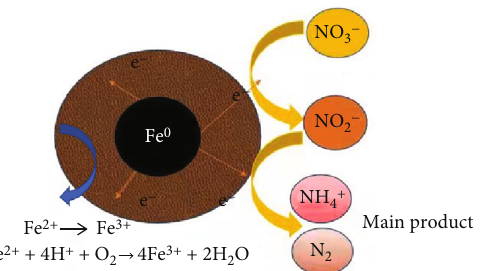
Figure 9: NO -N removal mechanism of nZVI. ATP: attapulgite; 3 nZVI: nano-zero-valent iron.